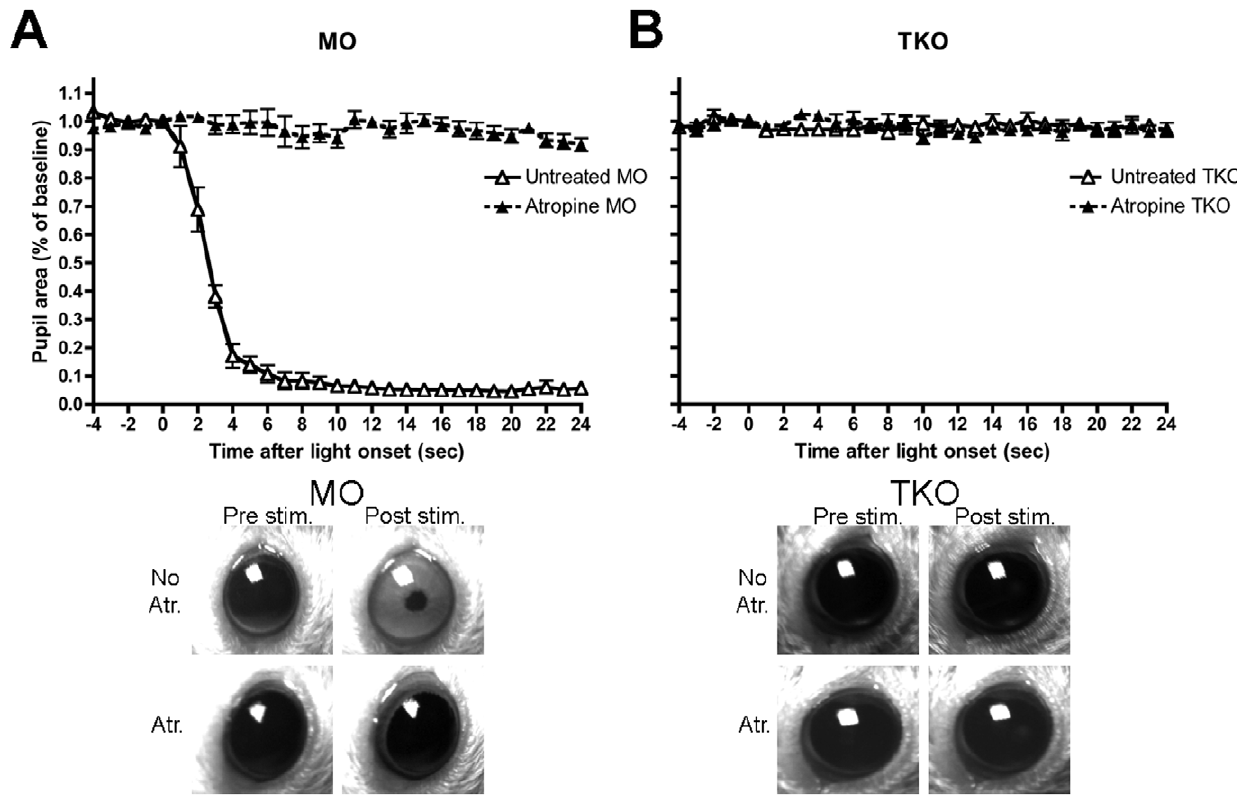
Figure 3. Effect of atropine on pupil size. In ( A ) MO ( rd/rd cl ), and ( B ) TKO ( Opn4 2 / 2 Gnat1 2 / 2 Cnga3 2 / 2 ) mice. Images below each graph illustrate pupil size pre- and post- light stimulation with atropine (Atr.) or without atropine (No Atr.) application in the two genotypes.